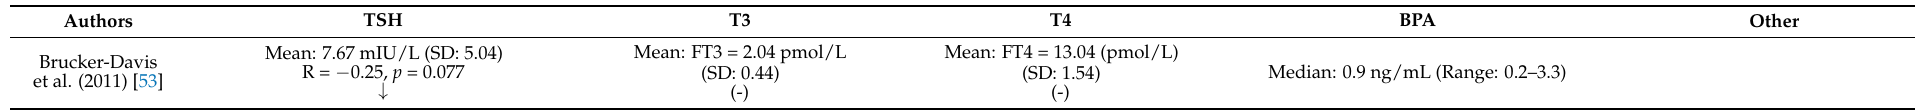
Table 3. Mean concentrations of BPA and thyroid